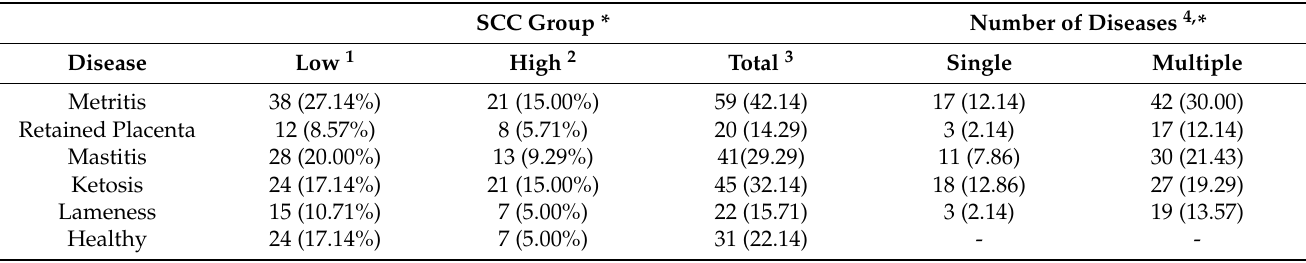
Table 1. Frequencies of the incidence rate for cows diagnosed with periparturient disease between SCC groups and number of